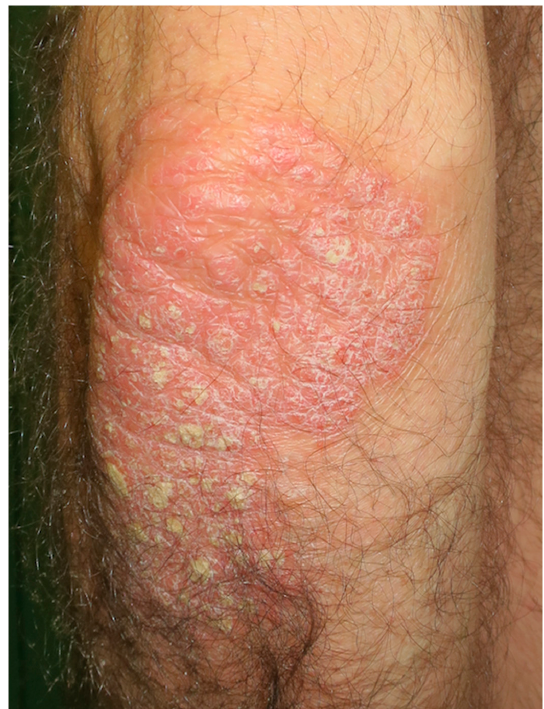
Figure 3. Extense plaque of psoriasis at the left elbow extensor side.